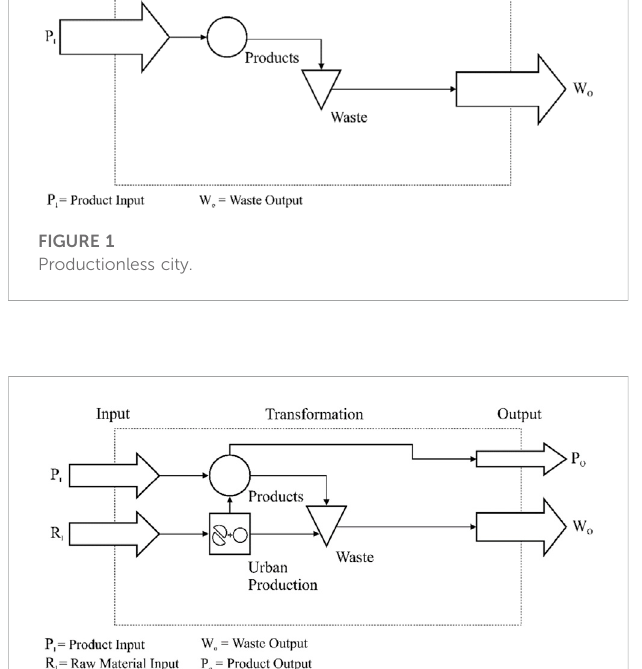
FIGURE 2 Productive city.